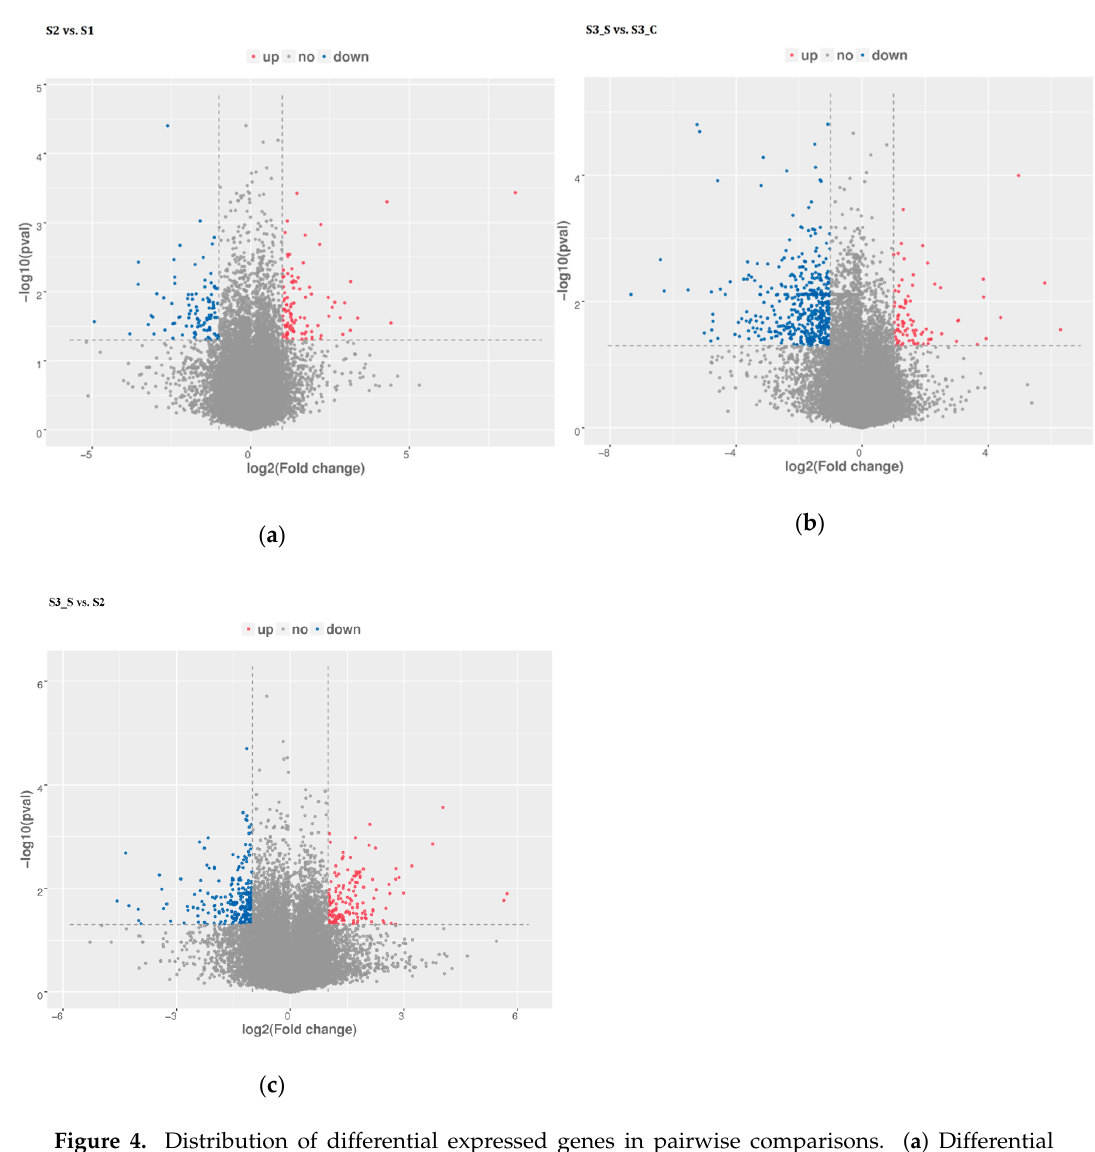
Figure 4. Distribution of differential expressed genes in pairwise comparisons. ( a ) Differential expressed genes in S2 vs. S1. ( b ) Differential expressed genes in S3_S vs. S3_C. ( c ) Differentially expressed genes in S3_S vs. S2.